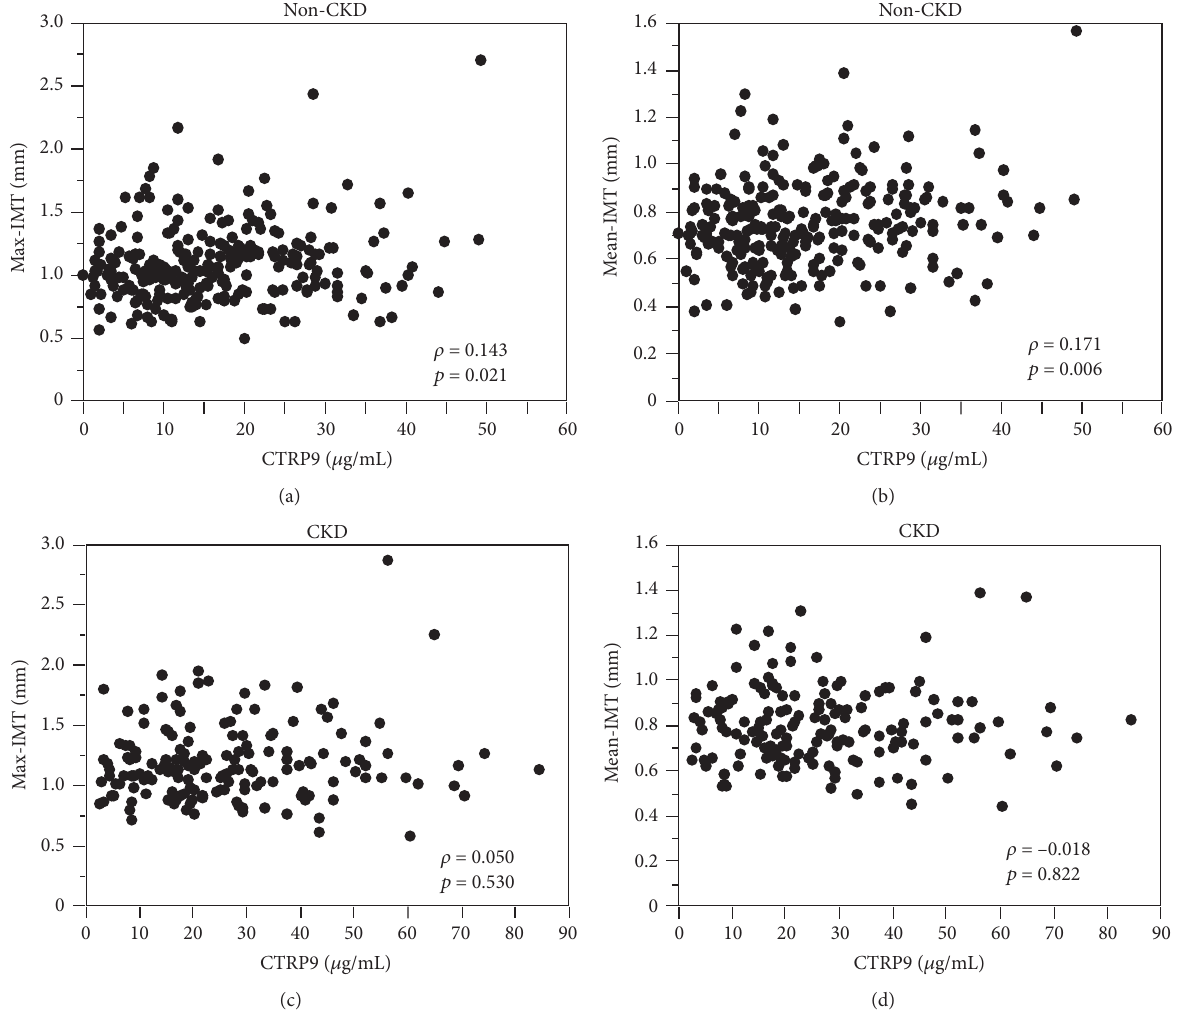
Figure 2: Association of plasma C1q/tumor necrosis factor-related protein-9 (CTRP9) levels with maximum intima-media thickness (IMT) (max-IMT) (a, c) or mean-IMT (b, d) of the common carotid artery in diabetic subjects without chronic kidney disease (CKD) (a, b) or those with CKD (c,